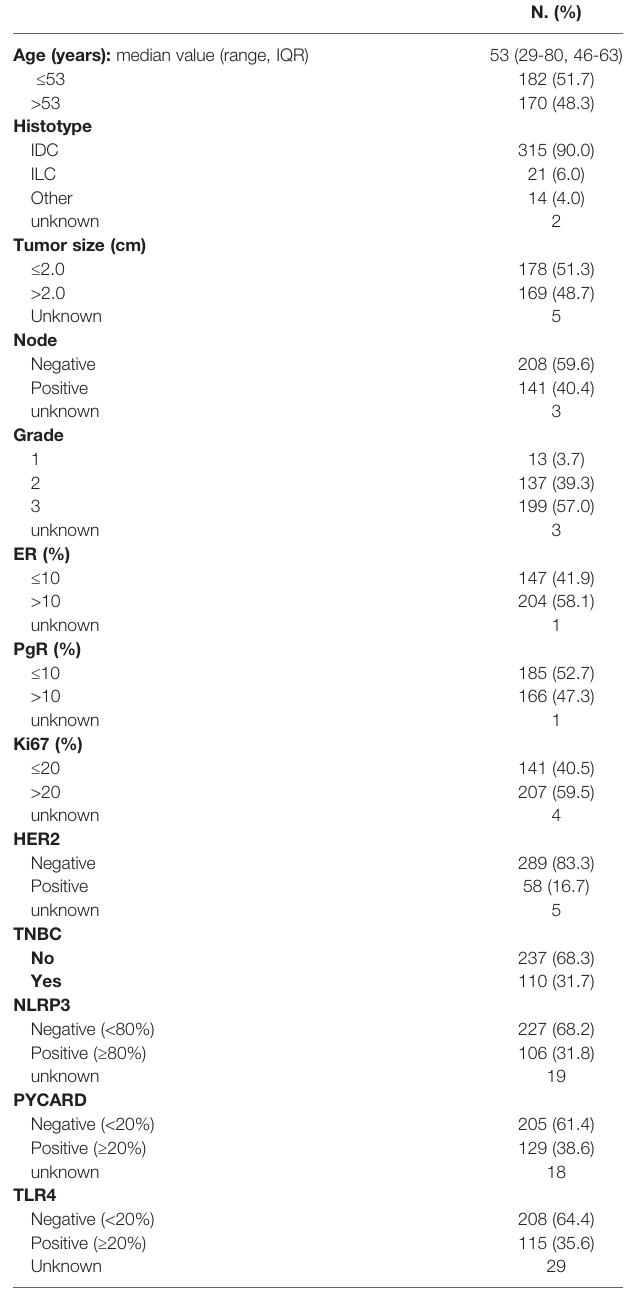
TABLE 1 | Tumor characteristics of 352 invasive breast cancer